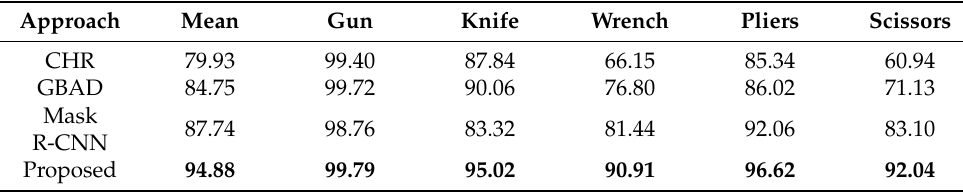
Table 4. Classification mean average precision (%) for SIXray10.